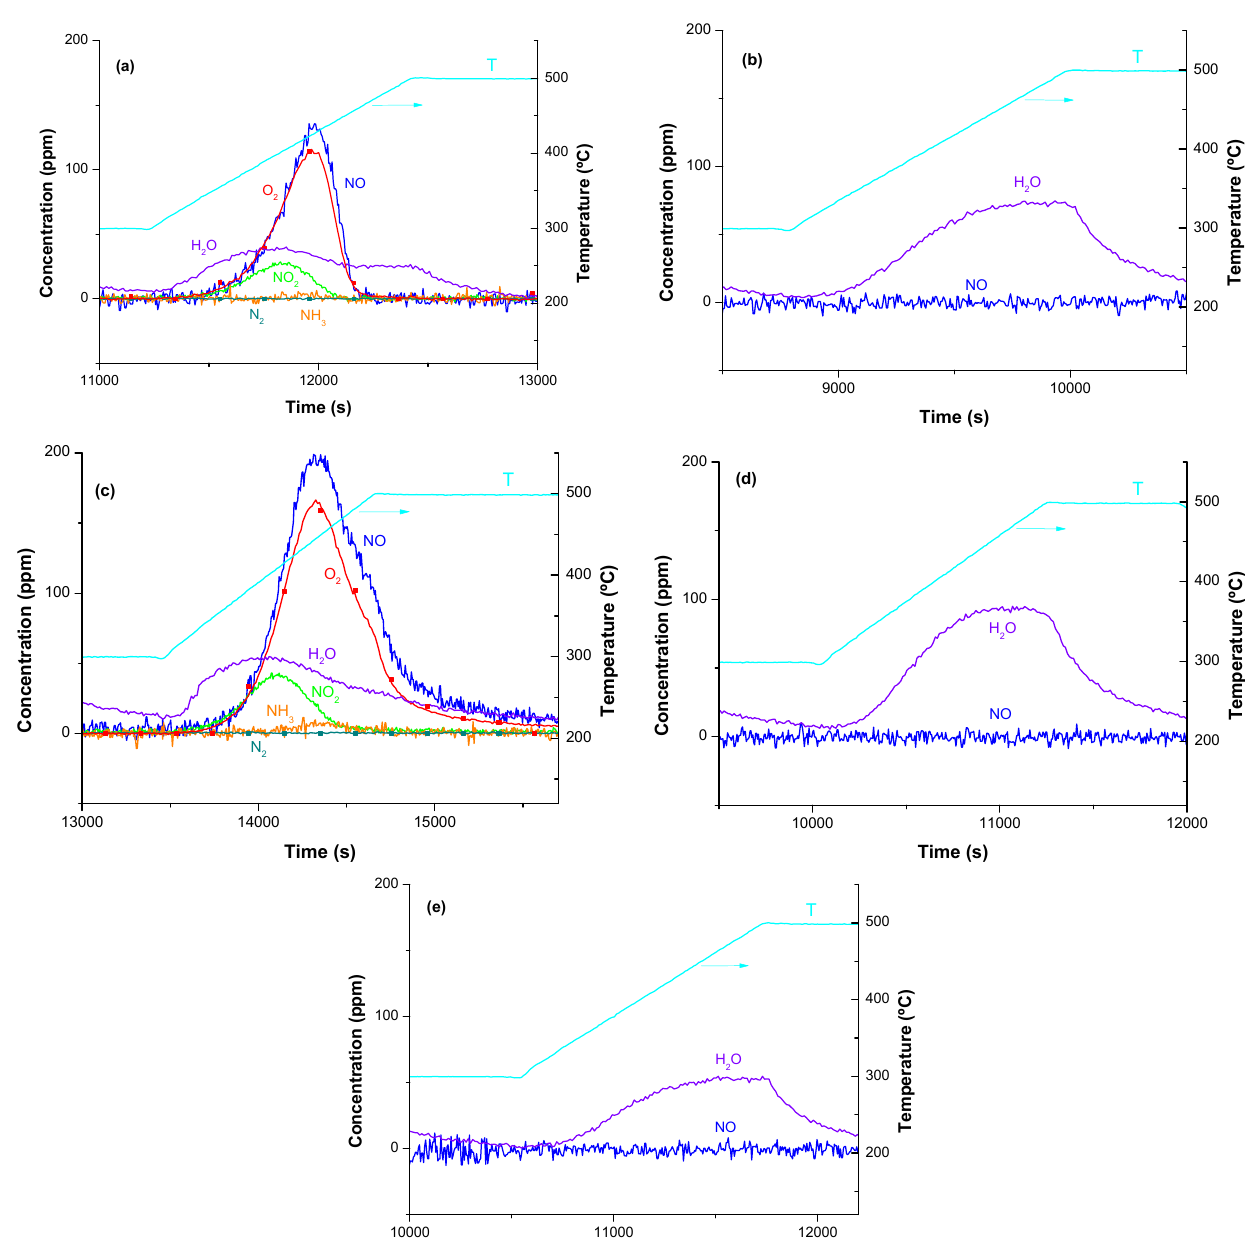
Figure 8. N 2 , NH 3 , NO, NO 2 , O 2 and H 2 O outlet concentrations during final TPD step, under He (after NO x storage and H 2 reduction at 300 °C), for the catalysts: ( a ) CZ; ( b ) Cu2/CZ; ( c ) Ba6/CZ; ( d ) Ba6/Cu2CZ; and ( e ) Ba11/Cu2CZ.